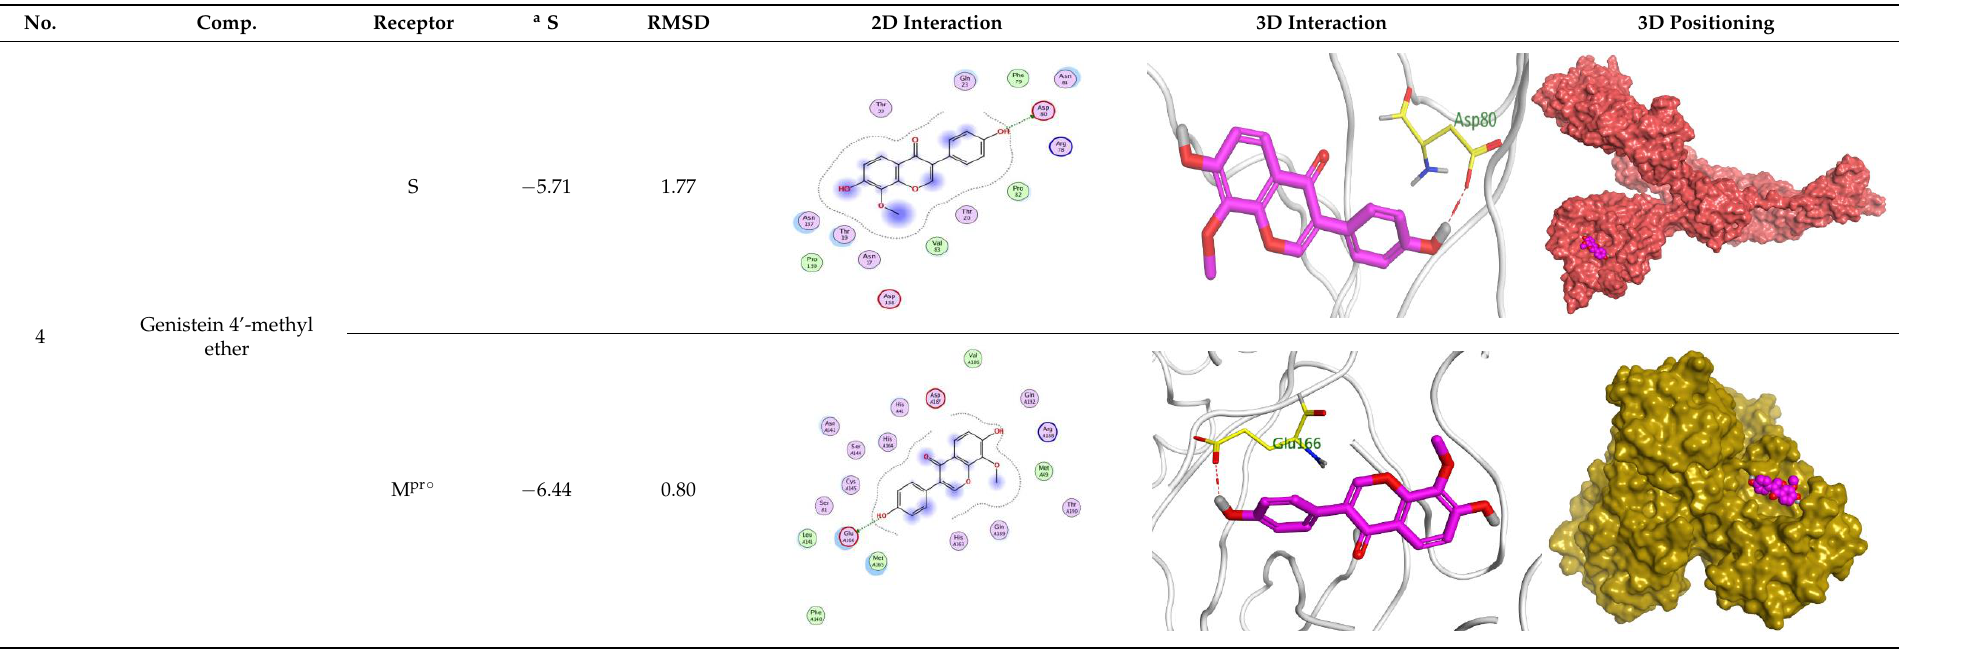
Table 3. Binding scores, RMSD, 2D binding, and 3D positioning of compounds from S. tomentosa ( 4 and 8 ) inside the S and M pr ◦ pockets of SARS-CoV-2, besides the co-crystallized O6K inhibitor of M pr ◦ .